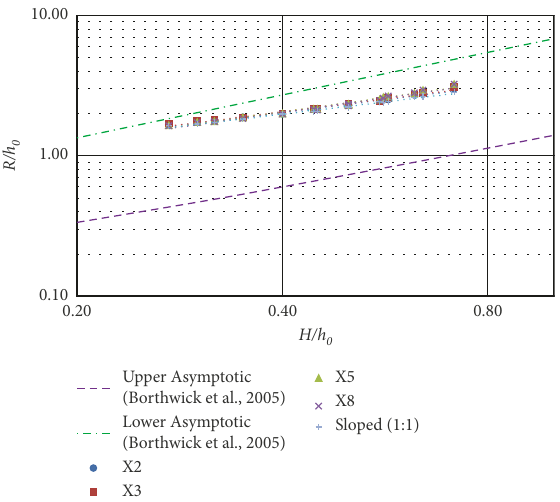
Figure 17: Model results of wave run-up for logarithmic and sloped